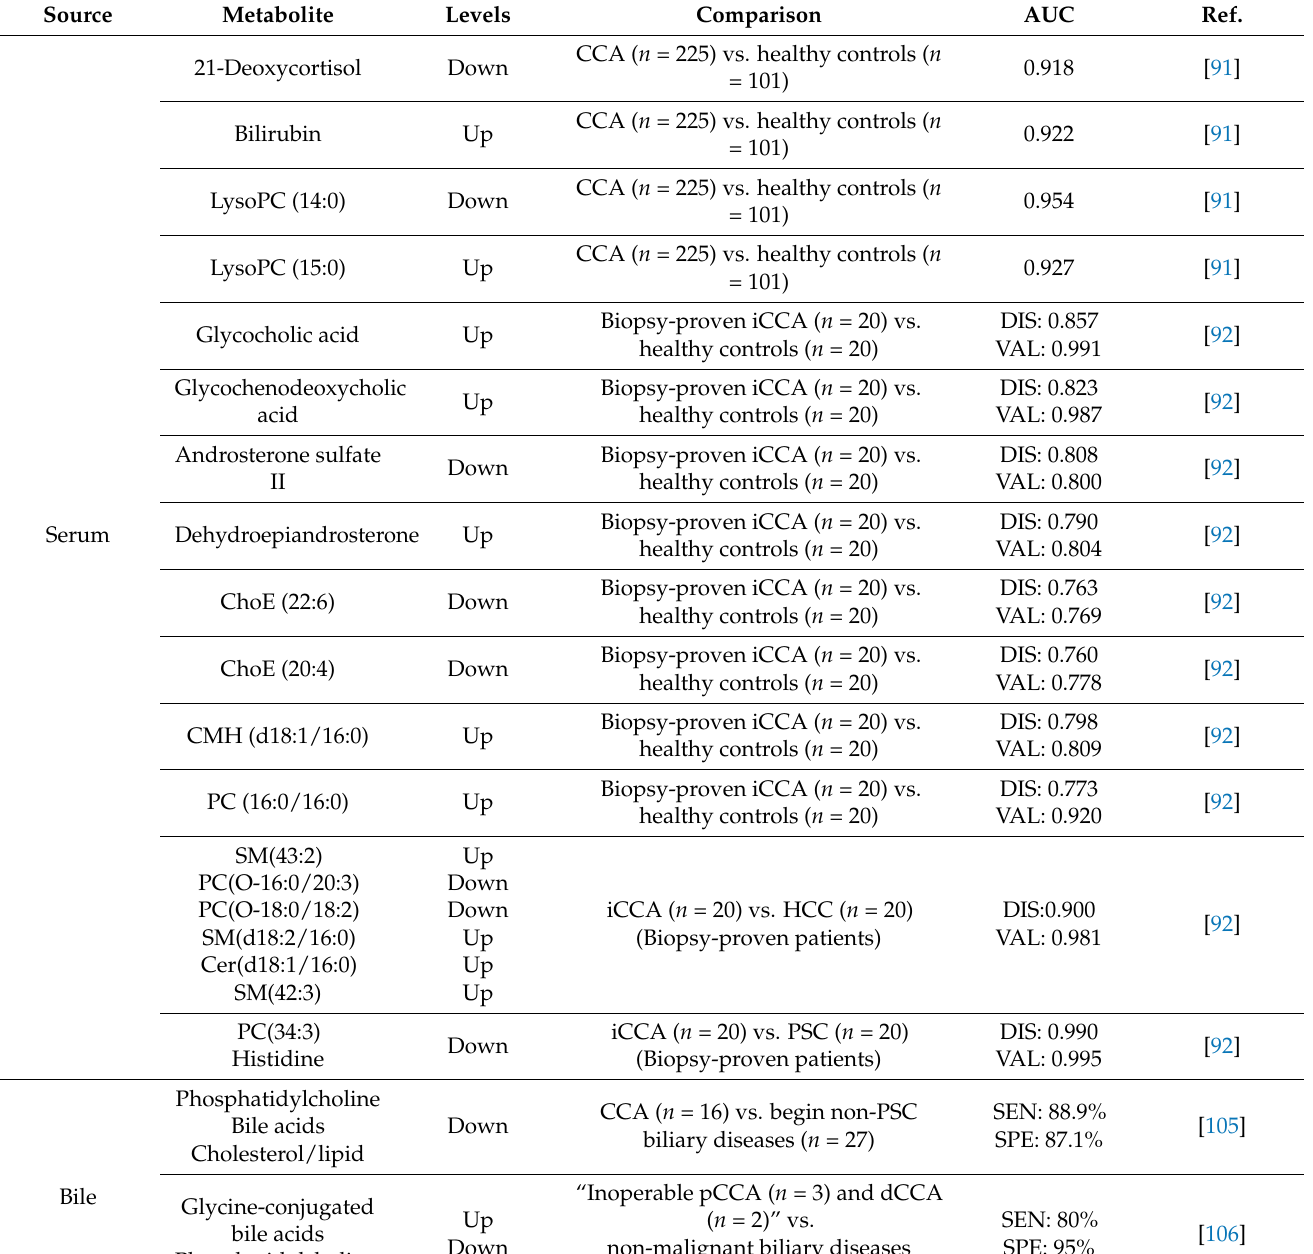
Table 3. Circulating metabolites with potential diagnostic value for